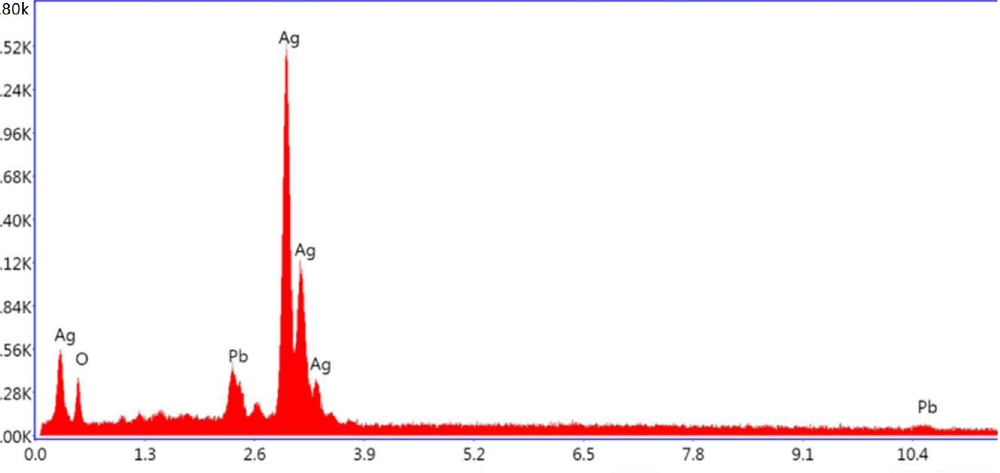
Figure 8. Energy-dispersive X-ray (EDX) spectrum of green-synthesized silver nanoparticles using the leaf extract of A. indica .